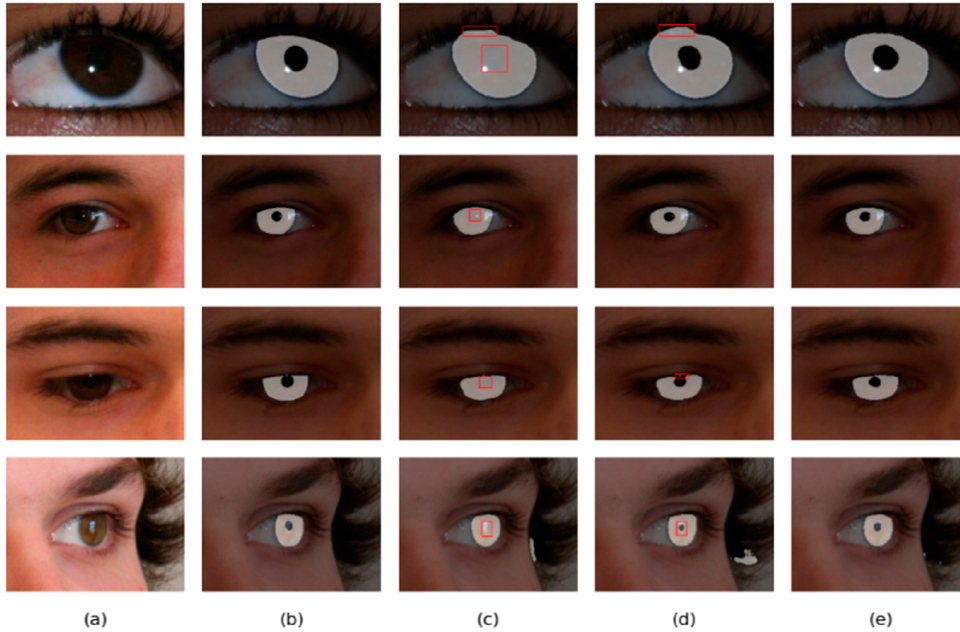
Figure 13. Segmentation results of different methods on the UBIRIS.v2 database: ( a ) Original image, ( b ) Ground truth, ( c ) results of Linknet, ( d ) results of DMS-UNet, and ( e ) results of the proposed network.